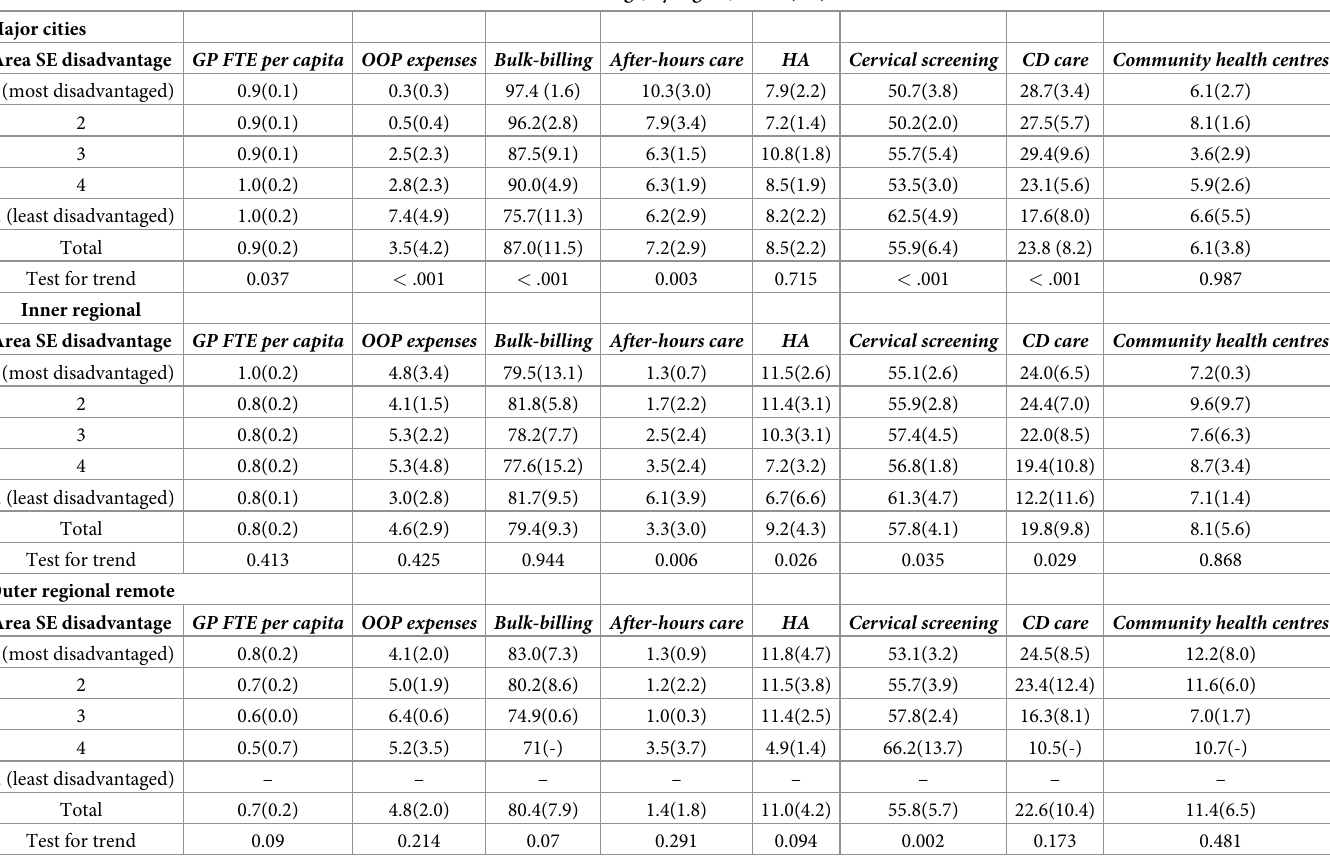
Table 3. Association of area PHC service characteristics with area disadvantage, by region, mean (SD). Major cities